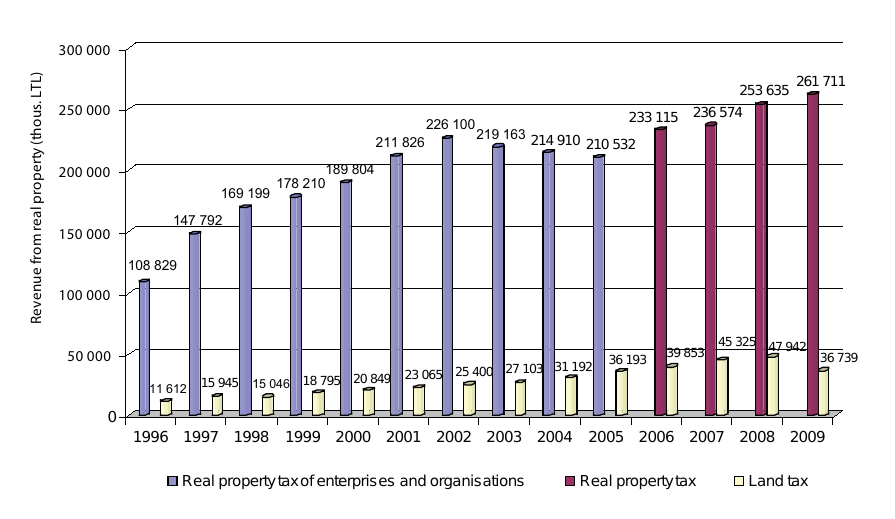
Figure 1. Revenues from real property taxes in Lithuania in 1996-2009 * , (2009 data is for 10 months, January -